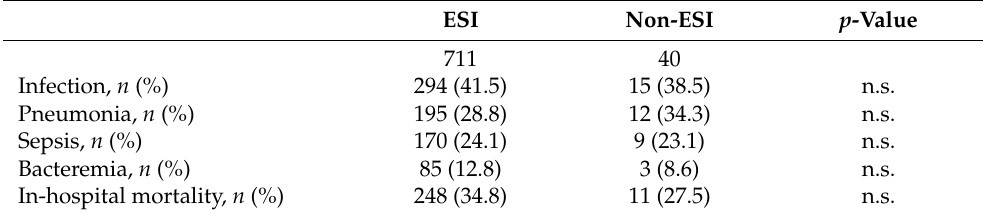
Table 4. Distribution of 30-day